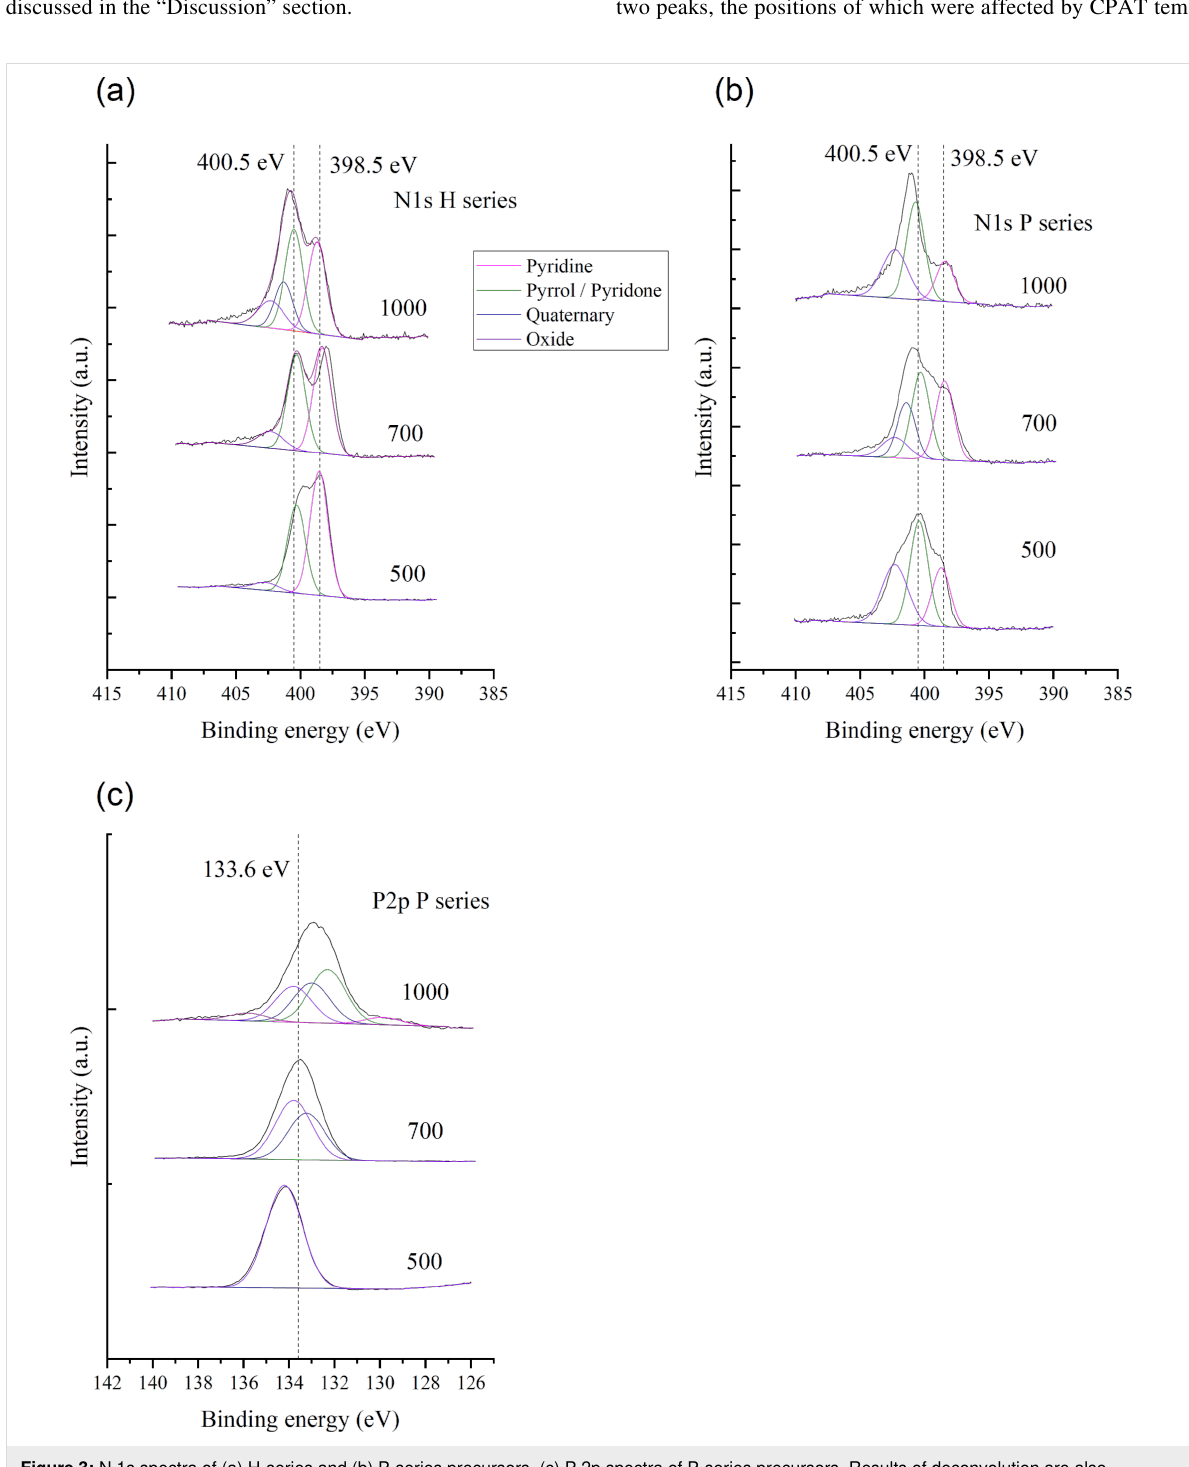
the correlation between P/C ratio and N/C ratio in P-series pre- cursors and HP-series carbon materials. It indicates the pres- ence of some chemical interactions between the nitrogen in folic acid and the phosphorus in phosphoric acid, which will be discussed in the “Discussion”